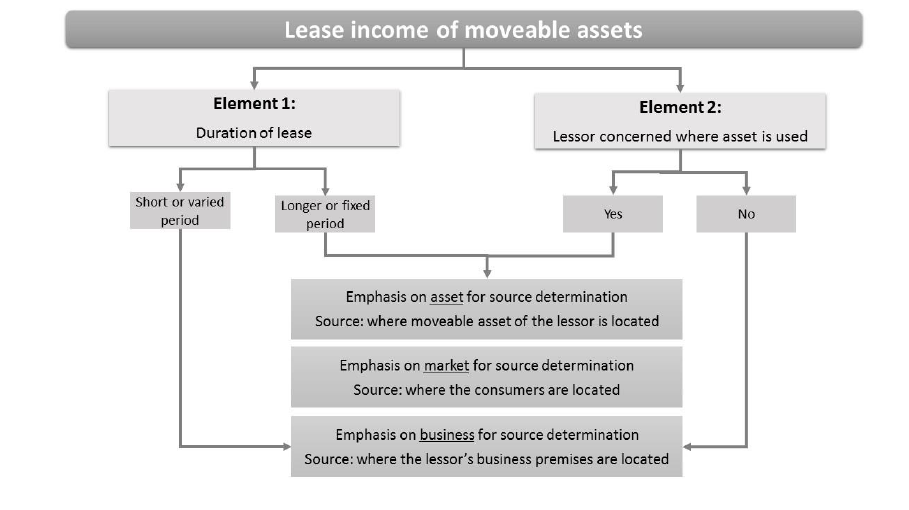
FIGURE 2: The source determination of lease income from moveable assets Source: Authors’ summary of the source determination of lease income from moveable